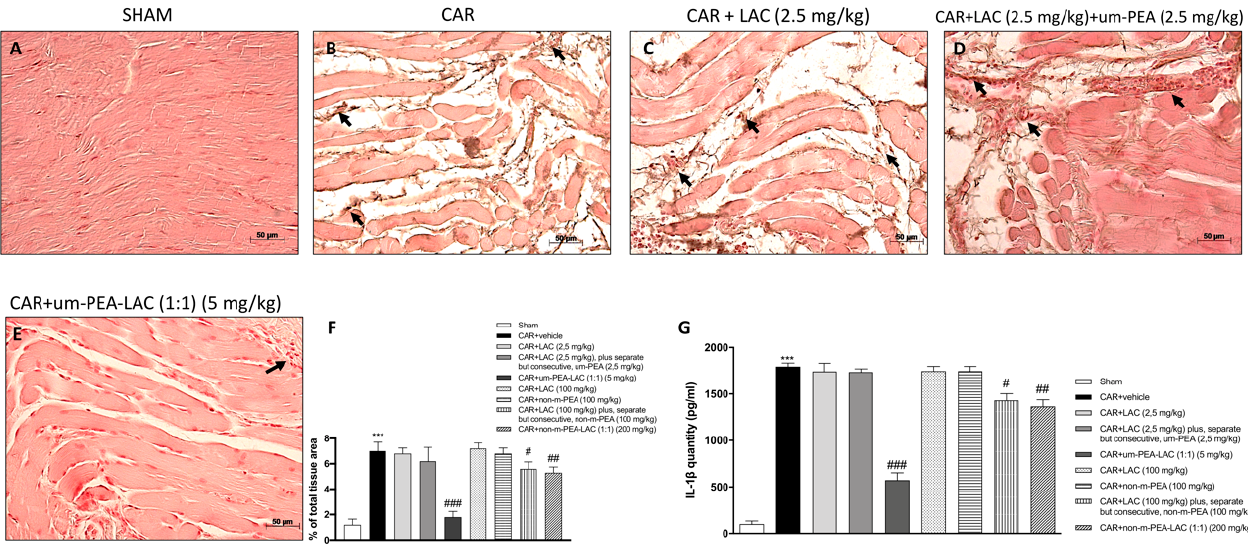
Figure 6. Efficacy of um-PEA and LAC treatment on IL-1 β expression. Tissues from CAR injected-animals displayed positive immunostaining for IL-1 β ( B , F ), compared to the sham group ( A , F ). Um-PEA and LAC (5 mg/kg) administration decreased this expression ( E , F ); but also CAR + LAC (100 mg/kg) plus, separate but consecutive, non-m-PEA (100 mg/kg) and CAR + non-m-PEA and LAC (1:1) (200 mg/kg) treatments (data not shown), albeit less effectively. Other administrations, individually or mixed, did not show a significant difference in IL-1 β expression with the CAR injected-group ( C , D , F and data not shown). Black arrows indicate the positive staining for IL-1 β . Quantification of IL-1 β levels confirmed data ( G ). Data are representative of at least three independent experiments. Values are means ± SEM. One-Way ANOVA test. *** p < 0.001 vs. sham; # p < 0.05 vs. CAR; ## p < 0.01 vs. CAR; ### p < 0.001 vs. CAR.